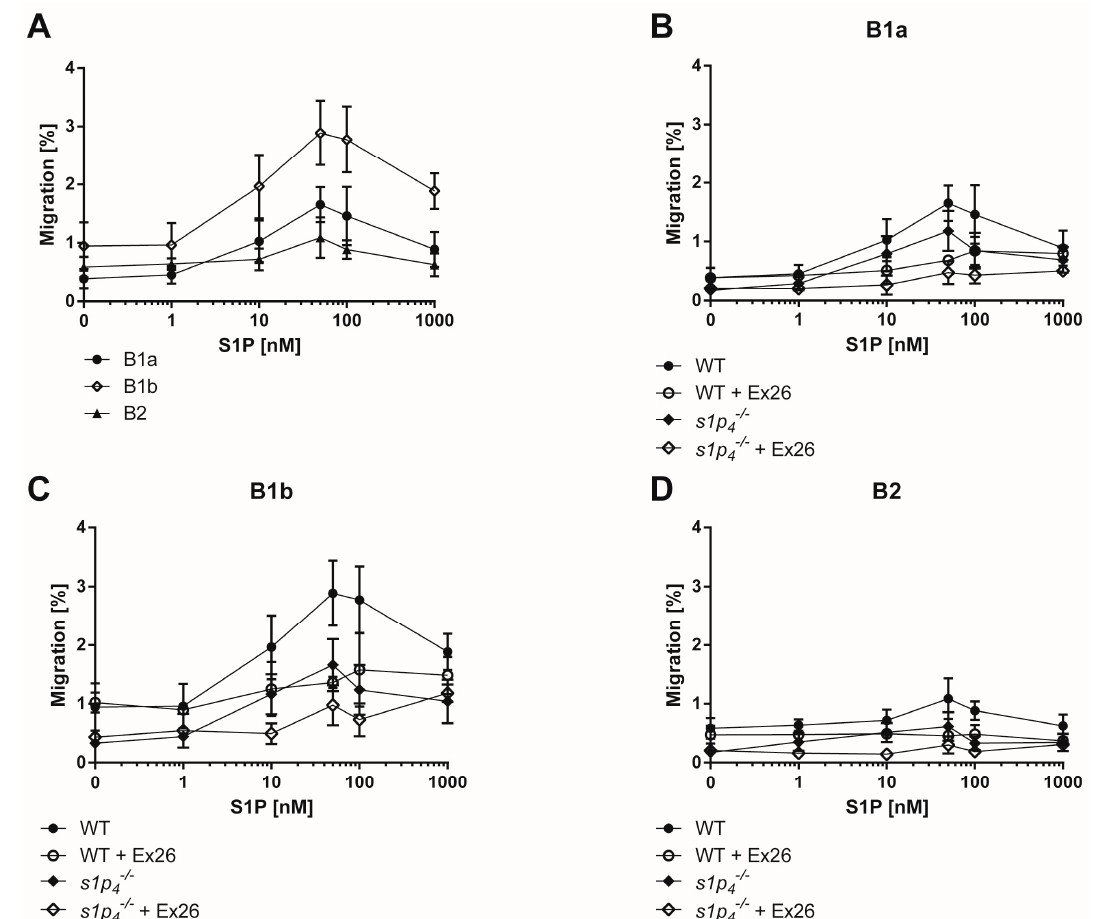
Figure 2. In vitro migration of peritoneal B cell subpopulations. In vitro chemotactic response to S1P was assessed in a transwell migration assay through a 5 µm membrane. ( A ) wild-type (WT) peritoneal cells; ( B ) Migration of B1a cells of WT or s1p 4 − / − with or without Ex26, ( C ) Migration of B1b cells of WT or s1p 4 − / − with or without Ex26, ( D ) Migration of B2 cells of WT or s1p 4 − / − with or without Ex26. Values represent the mean and standard error of n = 6 (without Ex26) or n = 3 (with Ex26) per condition.